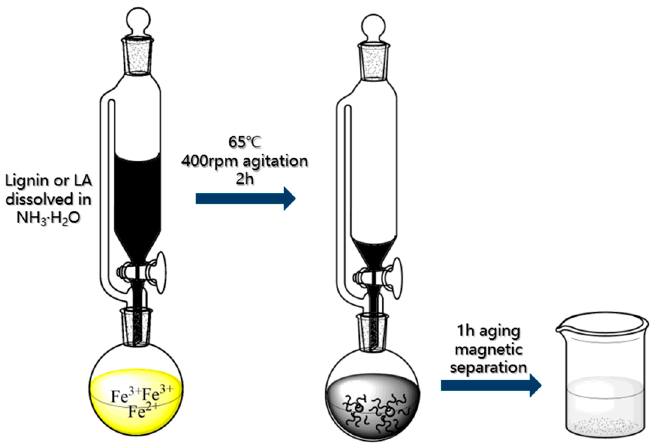
Figure 2. One-step fabrication of lignin coated Fe 3 O 4 nanoparticles (LMNPs) and lignin amine coated Fe 3 O 4 nanoparticles (LAMNPs).